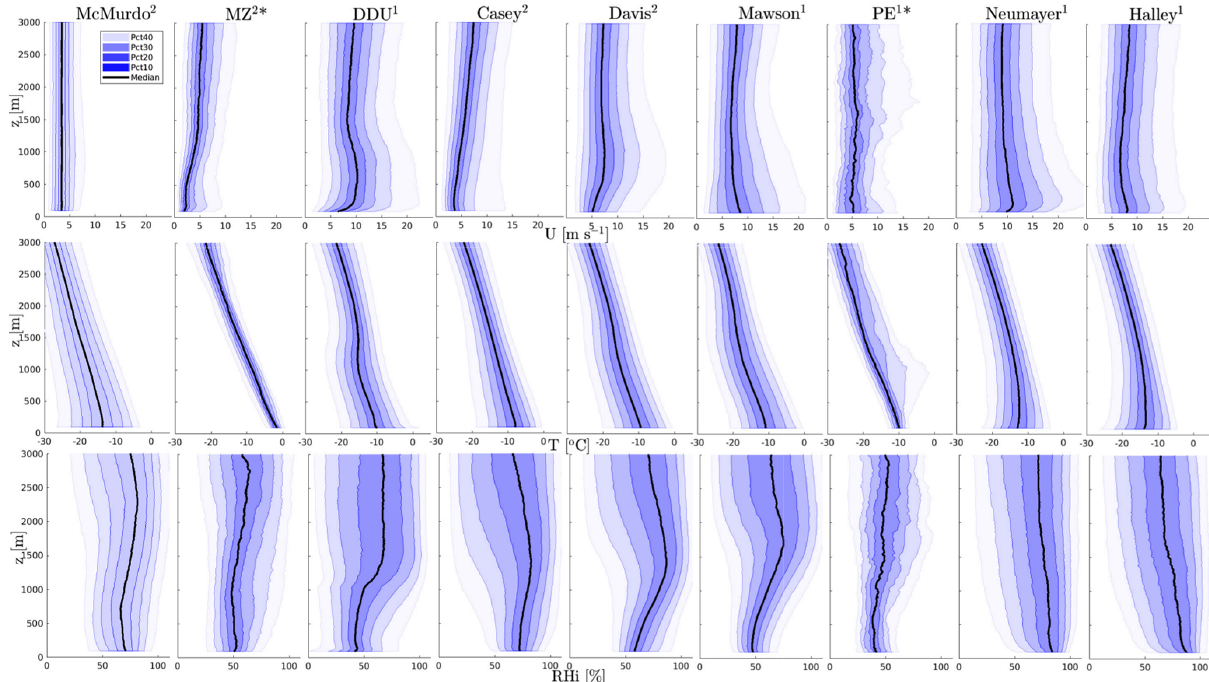
Figure 2. Vertical profiles of the annual wind speed (top row), temperature (middle row) and relative humidity with respect to ice (bottom row) from radiosonde measurements at nine Antarctic stations. Black lines are the medians, colored lines refer to the 10th, 20th, 30th, 40th, 60th, 70th, 80th and 90th percentiles. In the legend, “Pct x ” refers to the shaded area that covers x percent of the data greater than the median and x percent of the data lower than it. The altitude z is above ground level. Numbers in exponential form next to station names in the title indicate the number of radiosoundings per day at the corresponding station. The “ ∗ ” symbol labels the two stations for which only data from December to February are